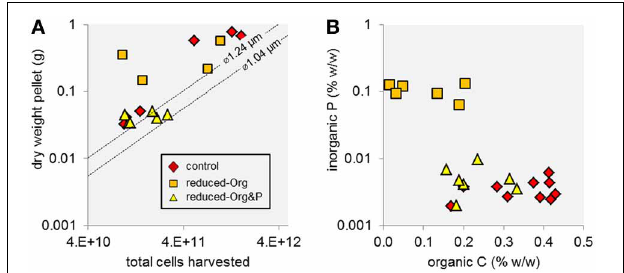
FIGURE 2 | Mass and elemental composition of T. kodakarensis cell pellets harvested from different culture media. (A) The dry masses of some cell pellets were higher than the projected mass of the total number of harvested cells (dashed lines), which was determined based on measurements of cell diameter ( ∅ = 1 . 04 or 1.24 µ m) and the cell mass:volume relationship described by Lipp et al. (2008), modified from Simon and Azam (1989), suggesting that non-cellular, insoluble material was harvested in addition to cells. Specifically, harvests of the reduced-Org media and the control media at stationary phase were heavier than the predicted mass of total cells by up to 340 and 550mg, representing a 22-fold and 5-fold excess of the projected mass of the pellet, respectively. Cells harvested from reduced-Org&P media and from control media at exponential phase were more consistent with predicted mass. (B) The reduced-Org harvests contained high amounts of non-cellular material that was rich in inorganic P relative to organic C. For this reason, these samples were excluded in further analysis of cellular